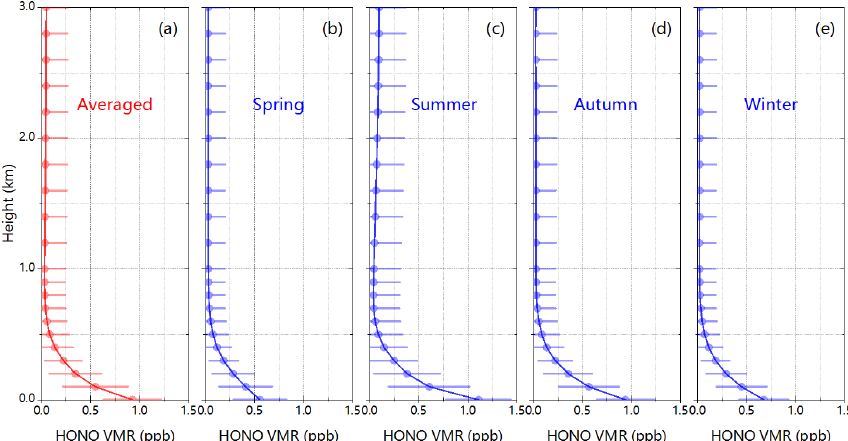
Figure 11. (a) Total-averaged, (b) spring-averaged, (c) summer-averaged, (d) autumn-averaged and (e) winter-averaged HONO vertical profiles from December 2017 to February 2019 at CAS